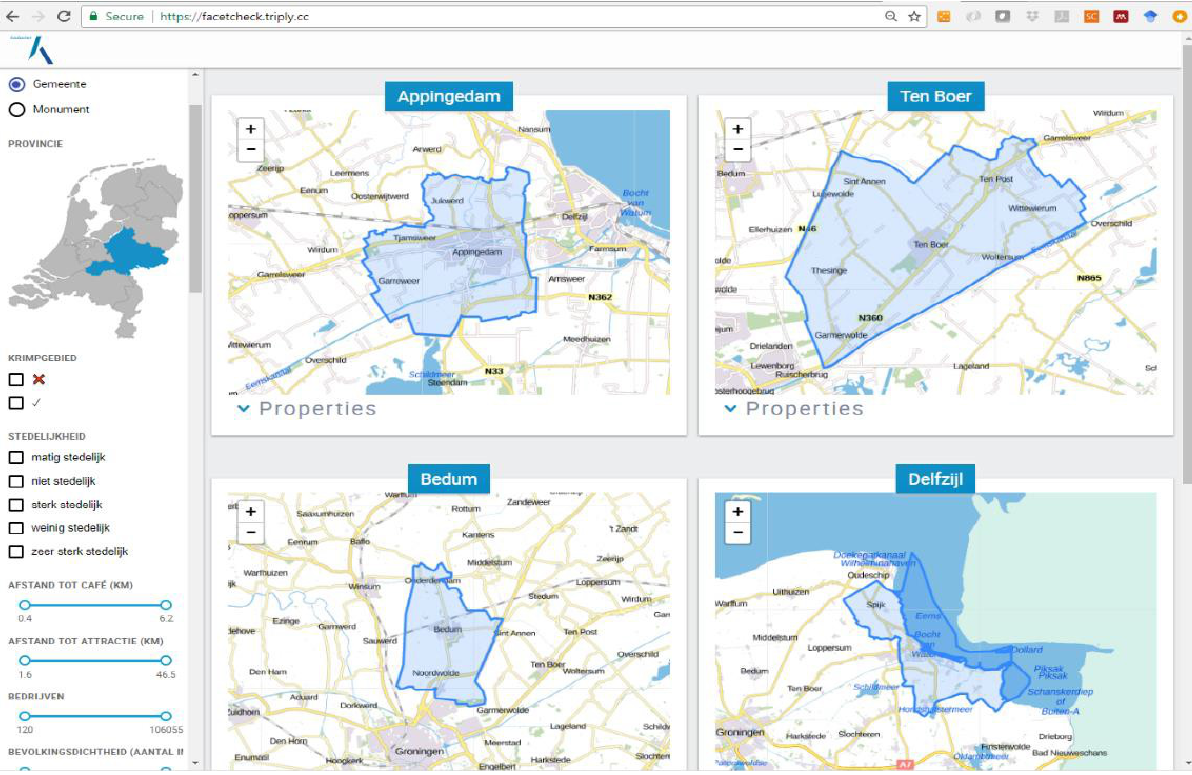
Figure 3. Screenshot of FacetCheck running of the Dutch neighborhood